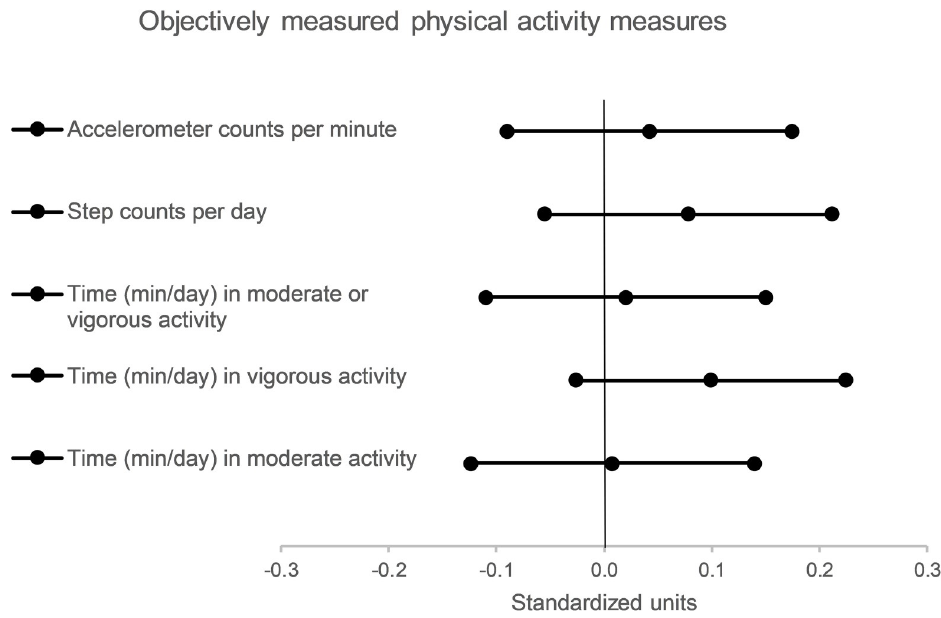
Fig 2. Differences in objectively measured physical activity between intervention and control groups at 3-month follow-up (expressed in standardised units and 95% CIs).